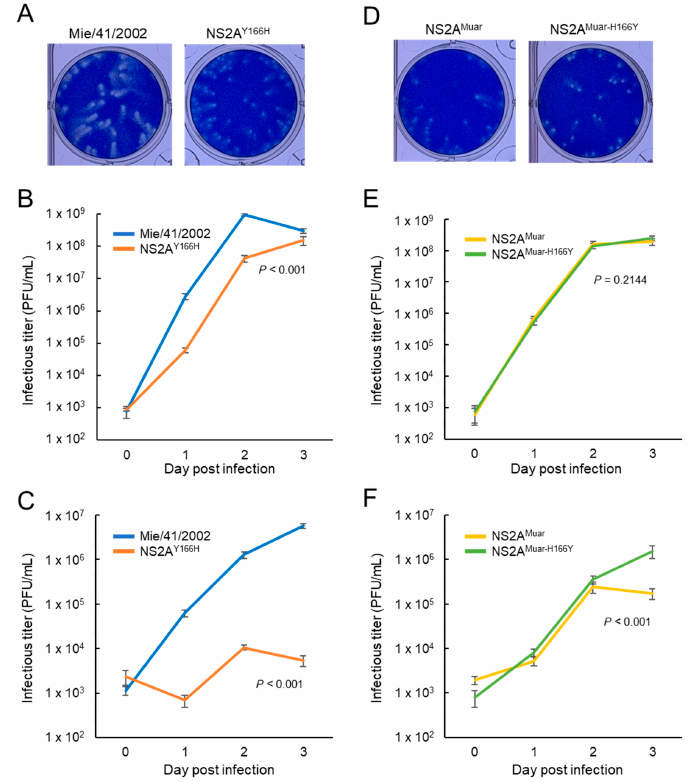
Figure 6. ( A ) Plaque phenotypes of Mie/41/2002 and site-directed mutant rJEV-NS2A Y166H -M41 (NS2A Y166H ). ( B and C ) Growth curves measured for Mie/41/2002 and NS2A Y166H in Vero ( B ) and Neuro-2a ( C ) cells. Cells were plated into 6-well culture plates and infected with the JEV strains at an MOI of 0.1 PFU/cell. Values: mean ± standard deviation from three independent experiments. Significance was analyzed using the two-way ANOVA test. ( D ) Plaque phenotypes of NS2A Muar and its site-directed mutant rJEV-NS2A Muar-H166Y -M41 (NS2A Muar-H166Y ). (E and F) Growth curves measured for NS2A Muar and NS2A Muar-H166Y in Vero ( E ) and Neuro-2a ( F ) cells. Cells were plated into 6-well culture plates and infected with the JEV strains at an MOI of 0.1 PFU/cell. Values: mean ± standard deviation from three independent experiments. Significance was analyzed using the two-way ANOVA test. 4. Discussion The GV strain Muar shows lower growth potential in murine neuronal cells than GI Mie/41/2002 [16]. This study was conducted to identify the genomic region that is related to this difference in in vitro growth property between the strains. It was shown that NS2A of Muar was one of the regions